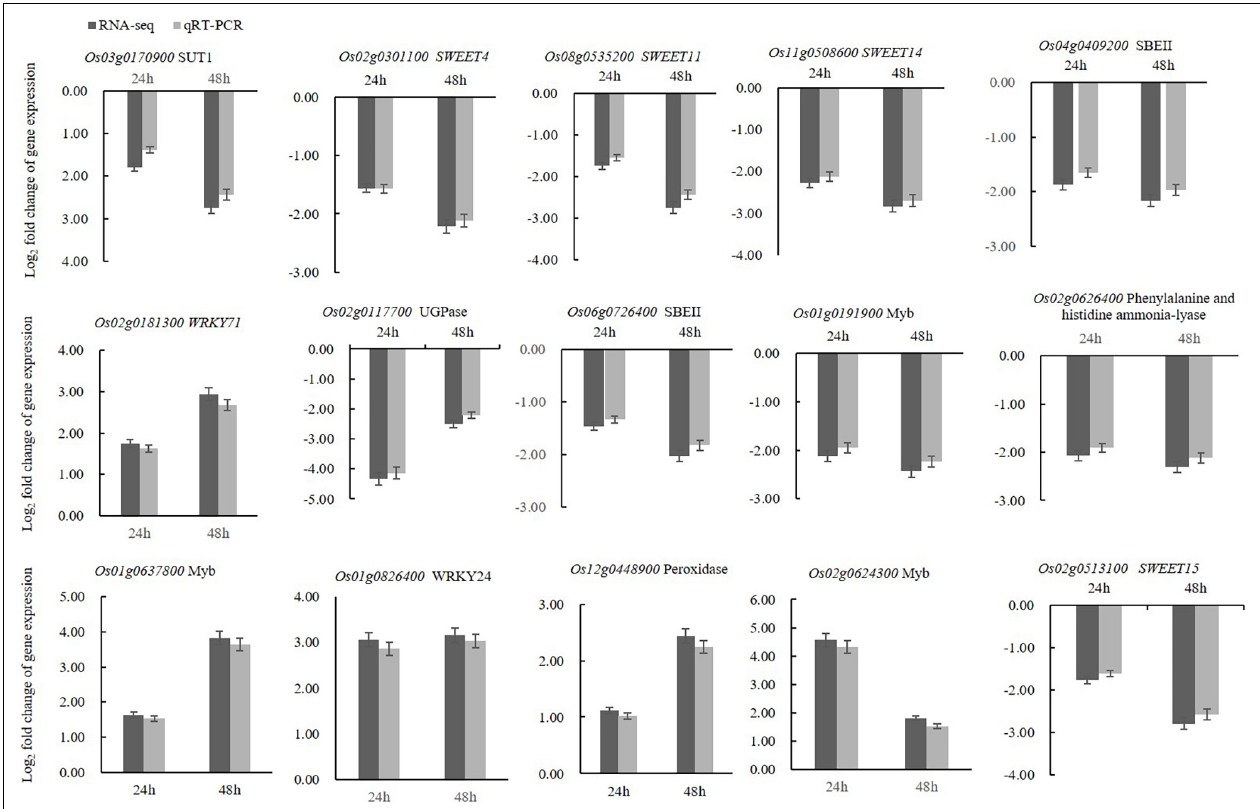
FIGURE 6 | qRT-PCR analyses of fifteen selected DEGs confirmed that these genes were upregulated or downregulated in the crude toxin treatment (CL) at both 24 and 48 h. Log 2 fold-change in CL transcripts with respect to the transcript levels in CK rice panicles is shown. Error bars represent the standard errors for three replicates of qRT-PCR